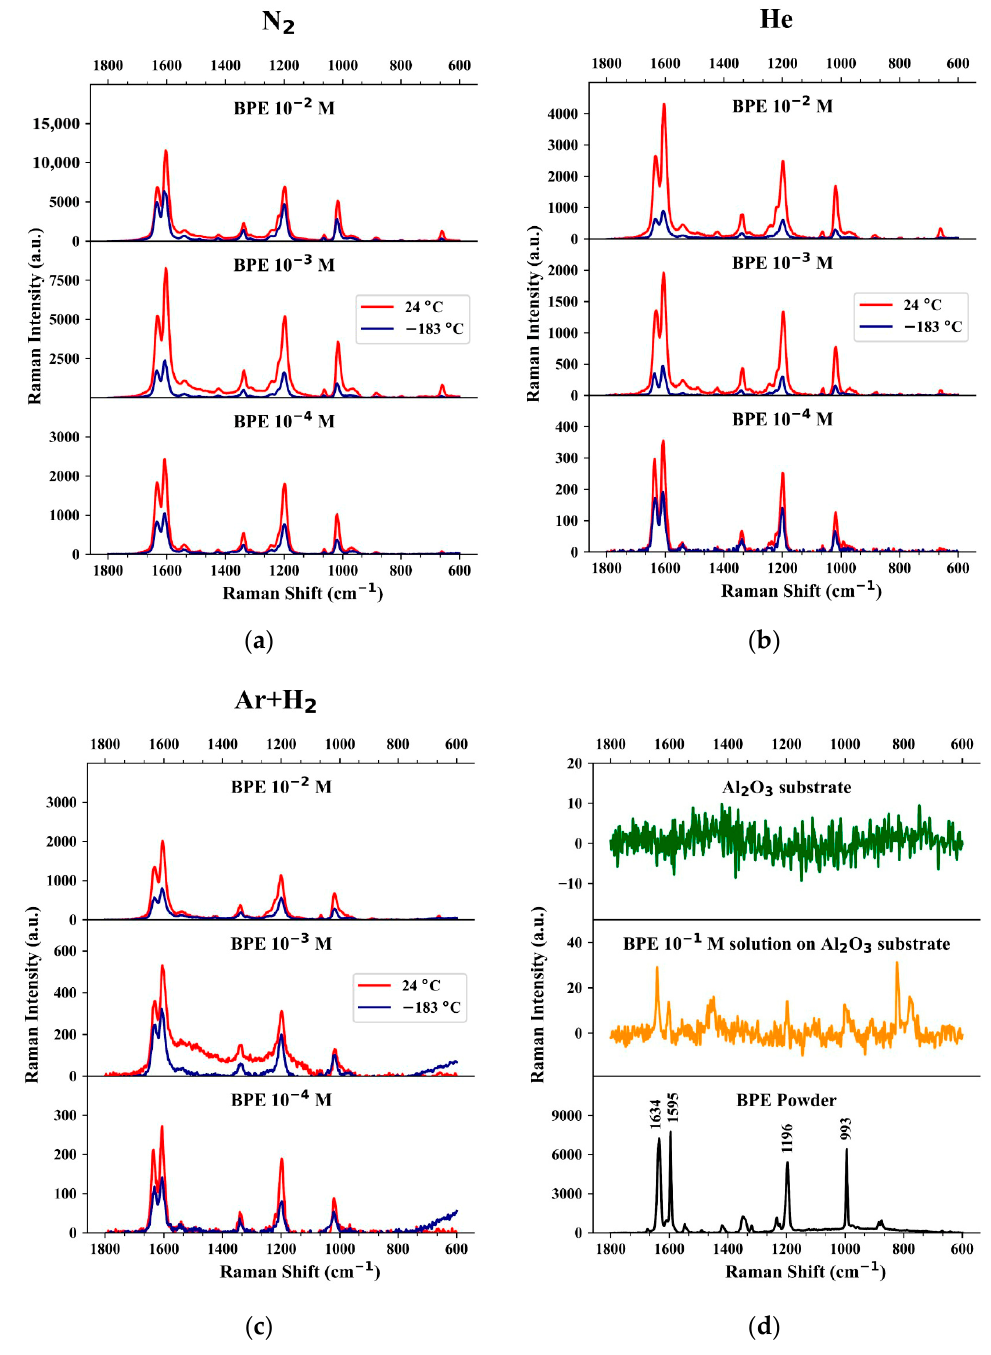
Figure 8. Raman spectra for BPE obtained on SERS structures of Au nanoparticles synthesized in various gaseous media (N 2 ( a ), He ( b ) and Ar + H 2 ( c )) spectra are scaled in pairs at temperatures of +24 ◦ C (red) and − 183 ◦ C (blue), and group of spectra ( d ) of an alumina substrate (green), of a 10 − 1 mol/L BPE solution (orange) supported on alumina, and of a dry BPE powder (black). The broad peaks appearing in Figure 8c (for nanoparticles synthesized at temperature –183 ◦ C and BPE concentrations of 10 − 3 and 10 − 4 mol/L at wave numbers from 500 cm − 1 to 700 cm − 1 ) are characteristic for the corresponding gold nanoparticles without applied dye. For each structure and each concentration of BPE, five to seven spectra were obtained, and among them we chose a spectrum with peak heights close to the median. When evaluating the signal amplification, we focused on the characteristic peaks indicated